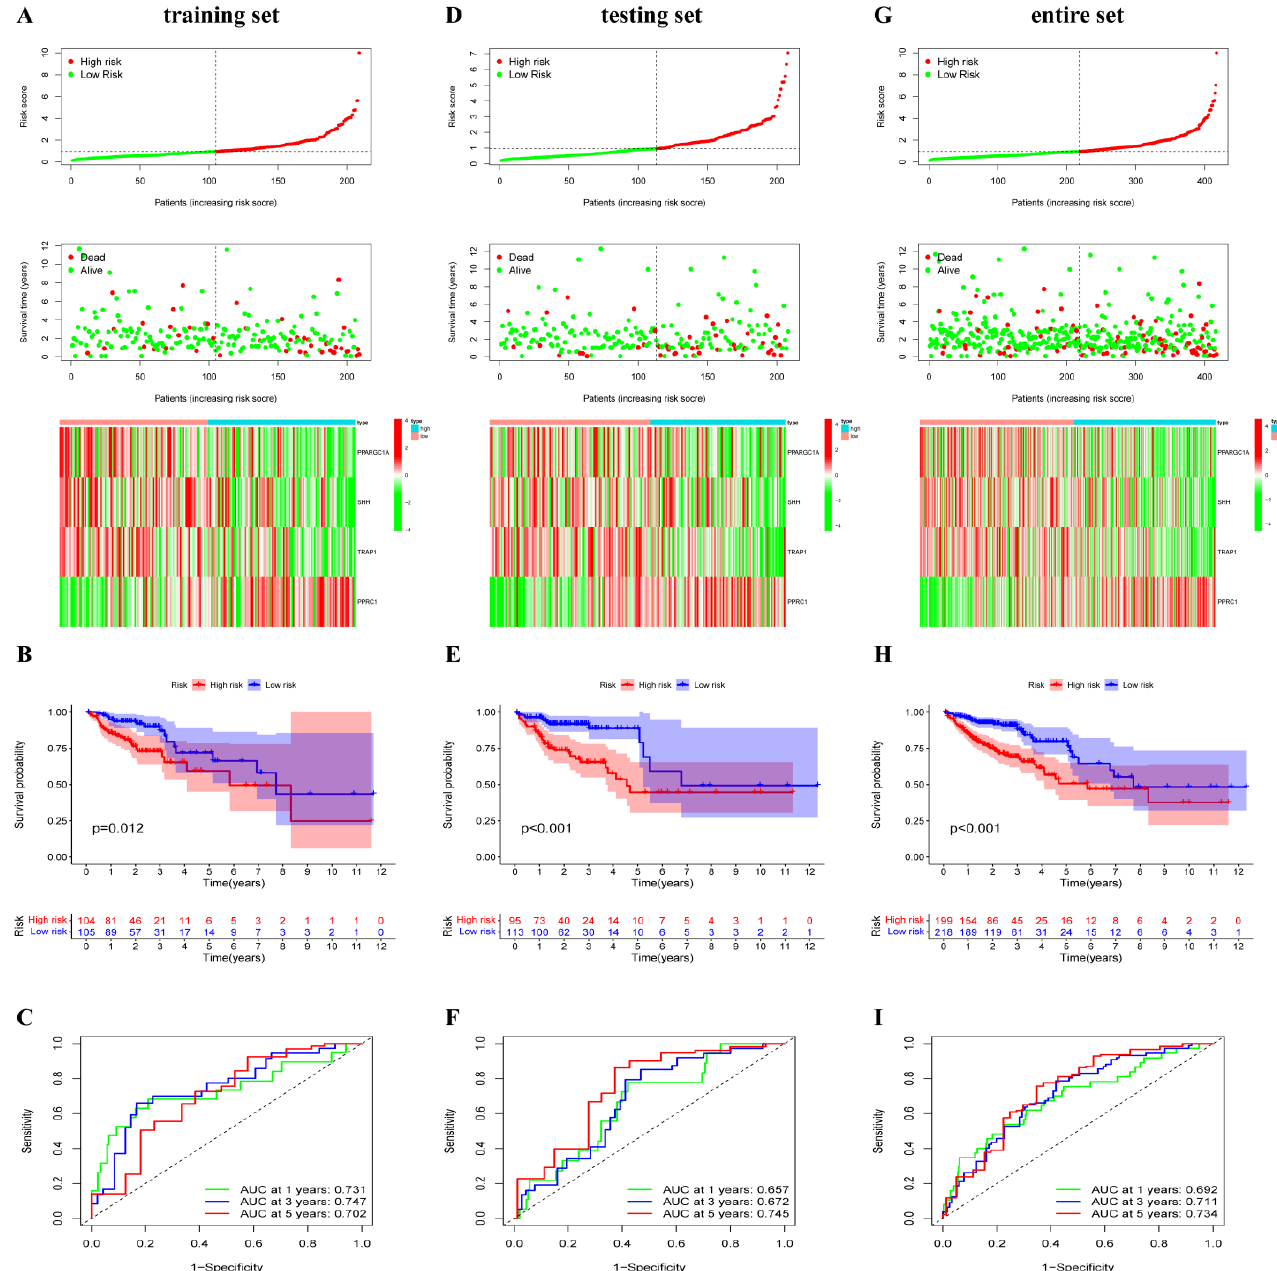
Figure 2. Construction and validation of the oxidative phosphorylation (OXPHOS)-related gene prognostic signature in the training, testing and entire set. ( A , D , G ) The risk curve displayed risk score distribution of high-risk and low-risk groups. Scatter plot distributed the survival status and survival time, heatmap showed the expression profiles of four ORGs in high-risk and low-risk groups. ( B , E , H ) Kapan-Meier survival curves for overall survival (OS) of patients in high-risk and low-risk groups. ( C , F , I ) ROC analysis of risk score in predicting prognoses.